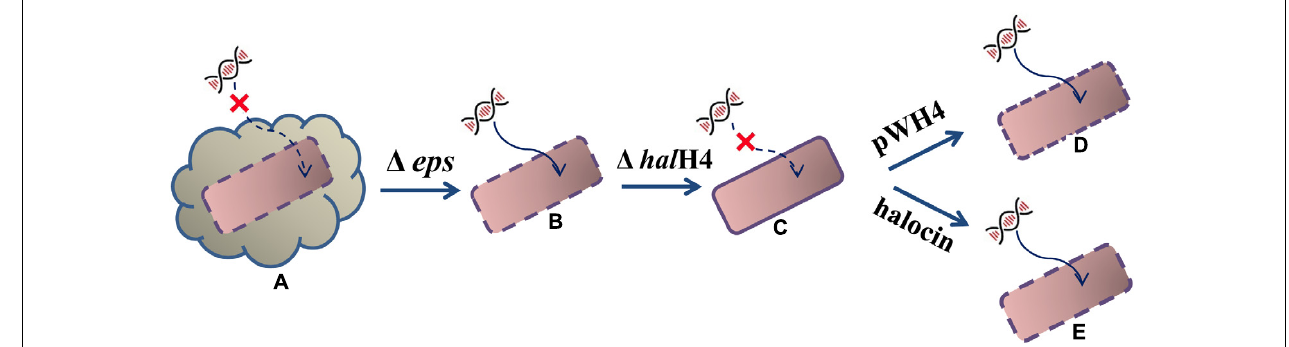
FIGURE 3 | Schematic diagram of halocin involved in DNA uptake. The starting strain DF50 (A) exhibiting an exopolysaccharide envelope and a smooth cell surface, are inefficient in taking up external DNA even though the hal H4 is active. When the exopolysaccharides envelope was removed resulting in the strain DF50- (cid:49) EPS (B) , the cell surface roughened, and they were prone to taking up external DNA. Then, the hal H4 was removed resulting in strain DF50- (cid:49) EPS (cid:49) halH4 (C) , the cell surface changed to smooth, and the entry of the external DNA was blocked. If the hal H4 was introduced back the strain DF50- (cid:49) EPS (cid:49) halH4 with plasmid pWH4 resulting in strain DF50- (cid:49) EPS (cid:49) halH4::H4 (D) , the cell surface presented rougher, and they were inclined to take external DNA. When the strain DF50- (cid:49) EPS (cid:49) halH4 was treated with halocin (E) , the cell surface recovered to rough, and external DNA can enter into the cells easily.